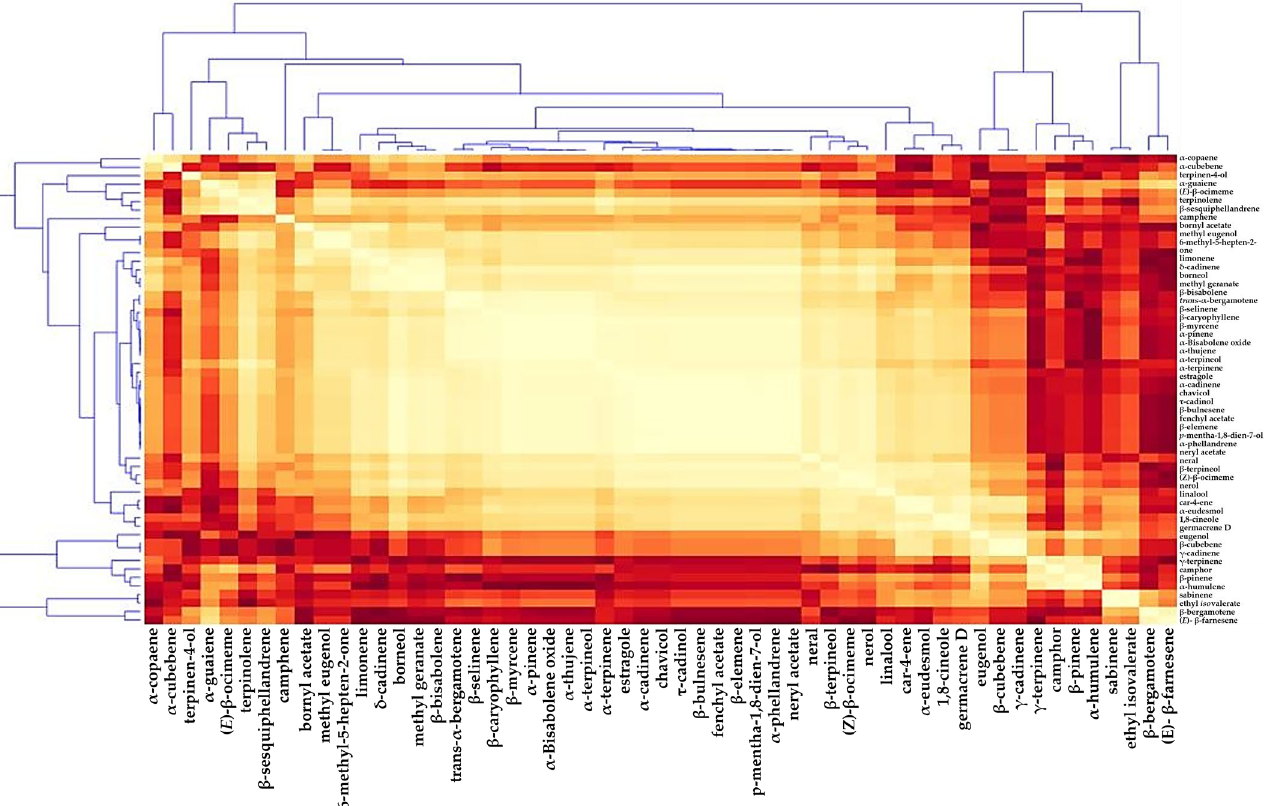
Figure 3. Absolute Pearson correlation heatmap distance (APCHD) and hierarchical clustering analysis (HCA) of the O. basilicum cell suspension extracts’ compound data throughout the initiation period (40 days). Each square represents the Pearson’s correlation coefficient of a pair of chemicals, with the correlation coefficient’s value expressed on the color scale by the intensity of yellow or orange hues.